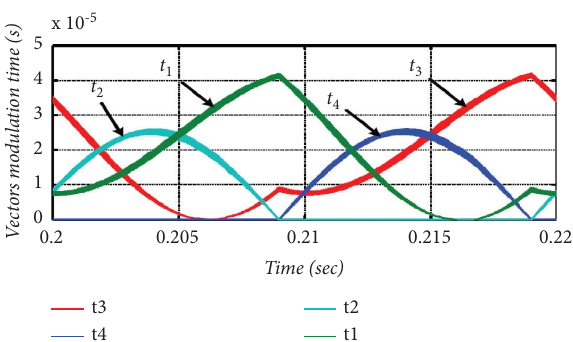
Figure 9: Switching time of voltage vectors in diferent regions for proposed controller under unbalanced grid voltage.